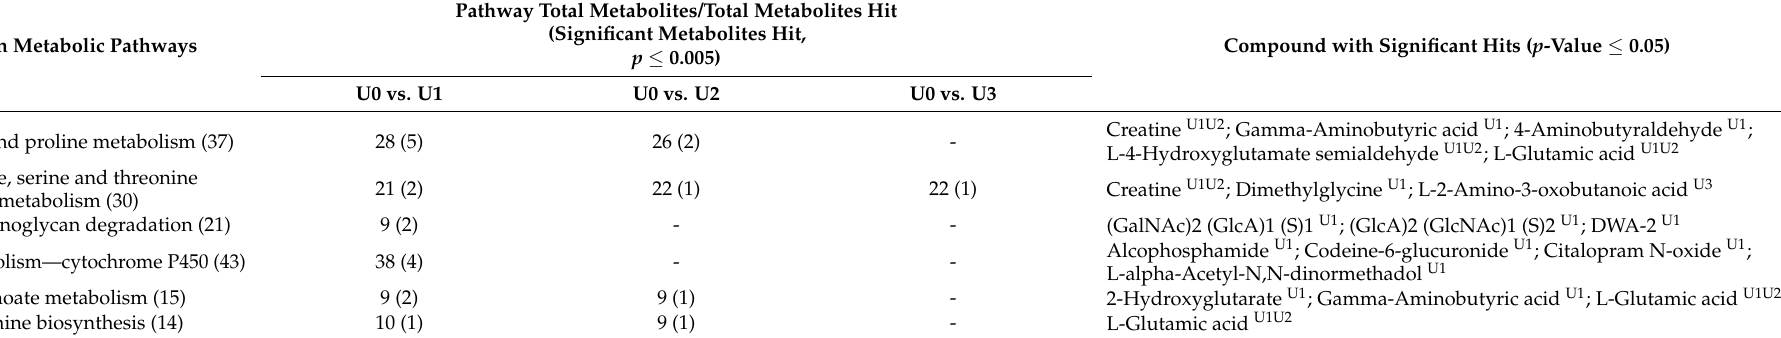
Table 5. Predicted human metabolic pathways based on mummichog algorithm for metformin 1000 mg at time-point U0 versus U1, U0 versus U2 and U0 versus U3 with the number of pathway metabolites, total metabolite hits and significant metabolite hits ( p -value ≤